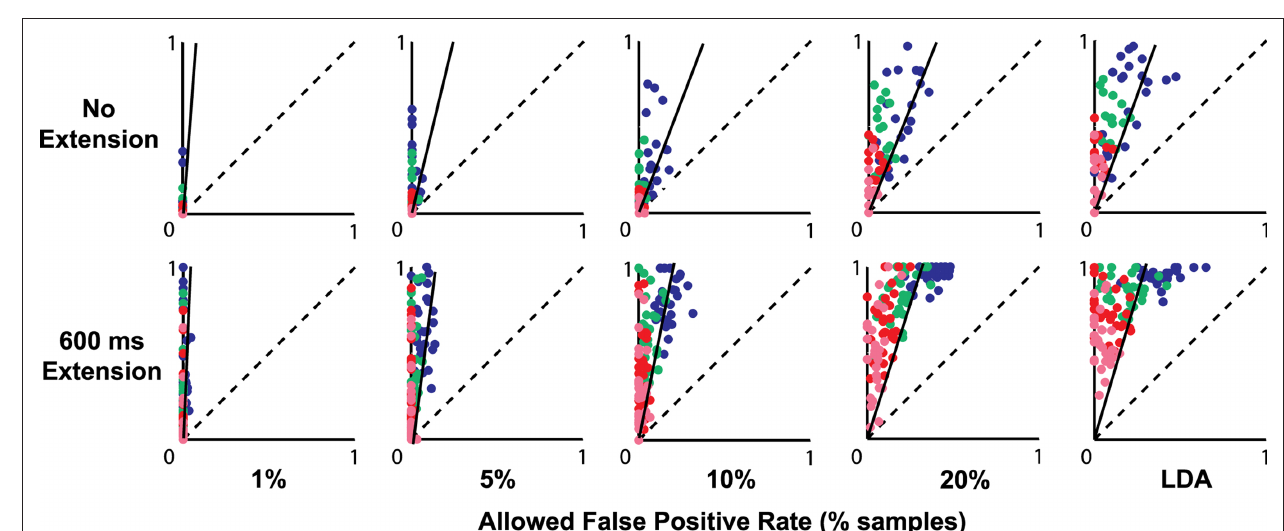
of the motor-planning phase was calculated using the median time-to-movement-onset calculated from the unaffected hand (no extension). In the bottom row, the assumed motor-planning phase was extended by 600 ms. Solid diagonal line in each plot indicates the ratio of the mean true- and false-positive rates calculated without regard to consecutive triggers.